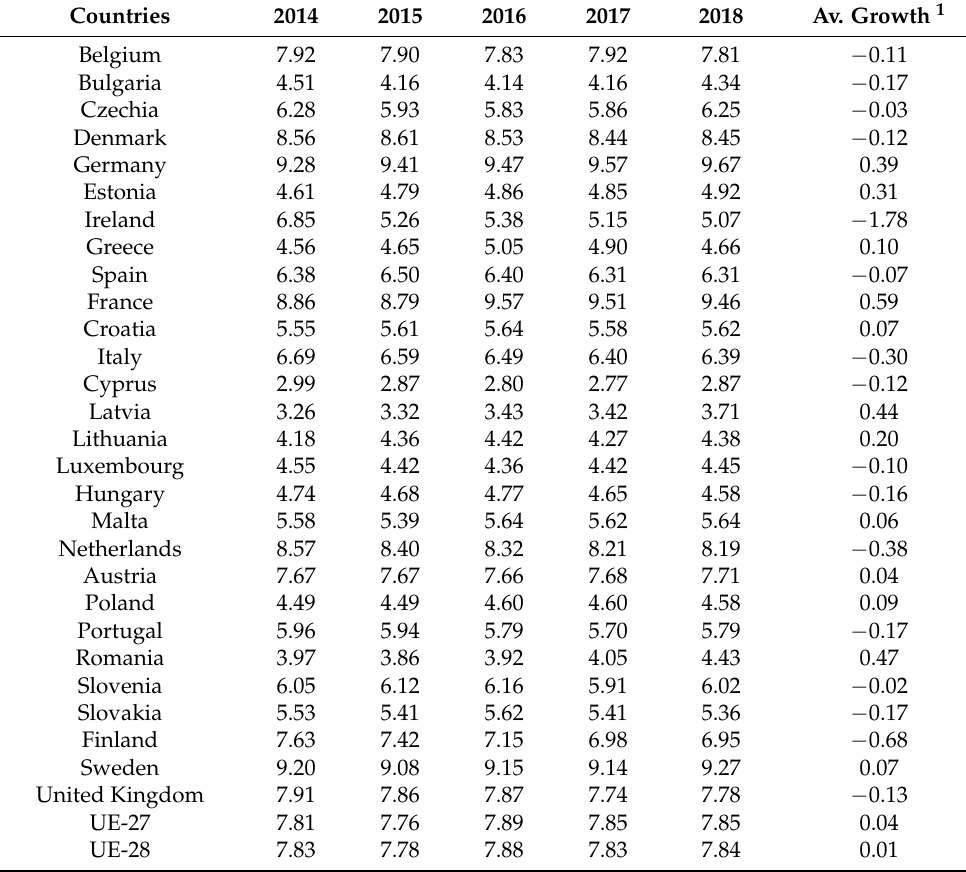
Table 5. Public Expenditure on Health (PSH) (%